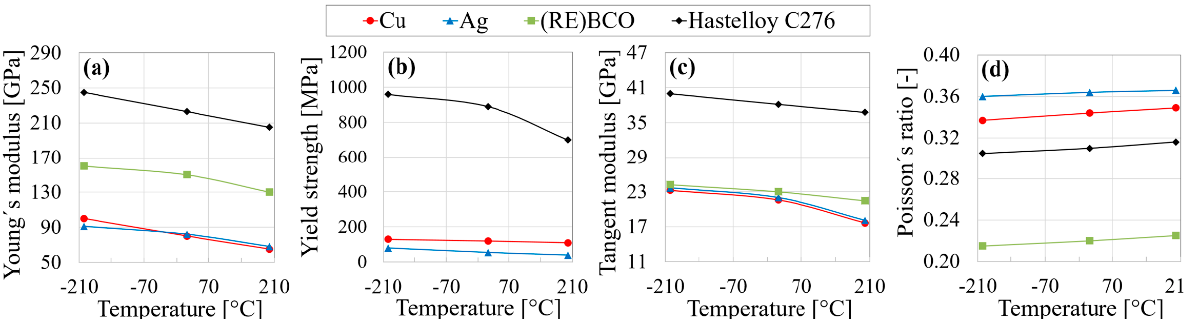
Figure 5. Tensile properties defined in material data source for numerical modeling: ( a ) Young´s modulus; ( b ) yield strength; ( c ) tangent modulus; ( d ) Poisson´s ratio.